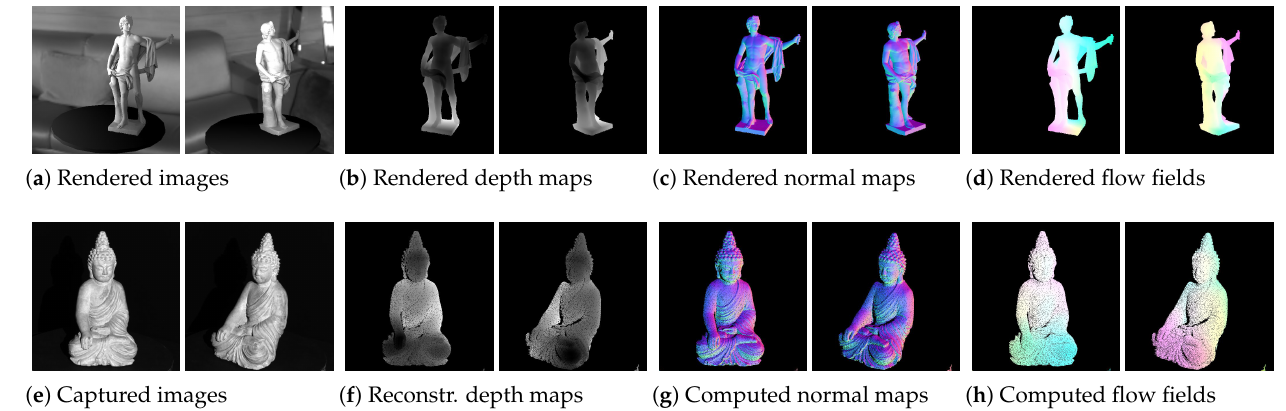
Figure 11. Example scene of the synthetic (top row) and real (bottom row) datasets. Each scene contains images, depth maps, normal maps and flow fields of two different camera views. In addition, a data file for each camera is stored that contains calibration information, camera position, light source position and minimal/maximal values of flows and depths in order to allow memory efficient saving of the